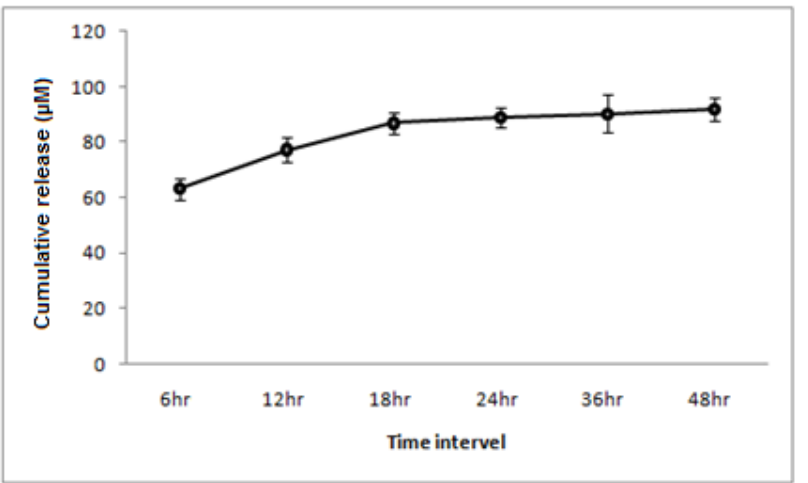
Figure 7. Line diagram for drug release efficiency from the specimen (10%wtg) from 6 to 48 h.